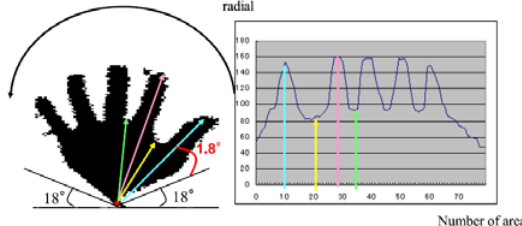
Fig. 6. Input vector with 80 dimensions for hand shape